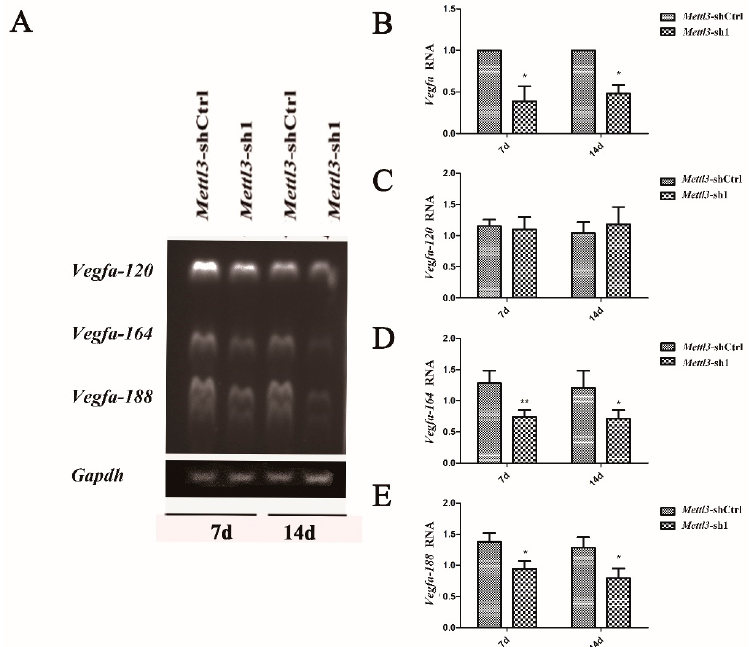
Figure 5. Effect of Mettl3 knockdown on the mRNA expression of Vegfa and its splice variants. ( A ) RT-PCR was performed to amplify mRNA products specific to Vegfa isoforms or an mRNA product specific to Gapdh . ( B ) The expression of Vegfa was decreased after Mettl3 knockdown, as indicated by the qRT-PCR results. ( C – E ) The mRNA expression of Vegfa isoforms was assessed with the expected mRNA sizes of 431 bp for Vegfa-120 , 563 bp for Vegfa-164 , and 635 bp for Vegfa-188 . Gapdh was used as an internal control for qRT-PCR and RT-PCR. The data are presented as the mean ± standard deviation of three independent experiments ( n = 3). Statistically significant difference relative to the shCtrl group (* p < 0.05; ** p < 0.01).